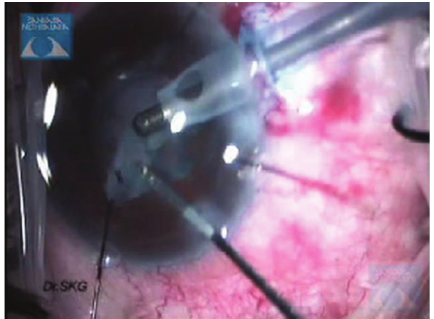
Figure 10: Intraoperative still surgical video clip showing irrigation and aspiration of the soft lens